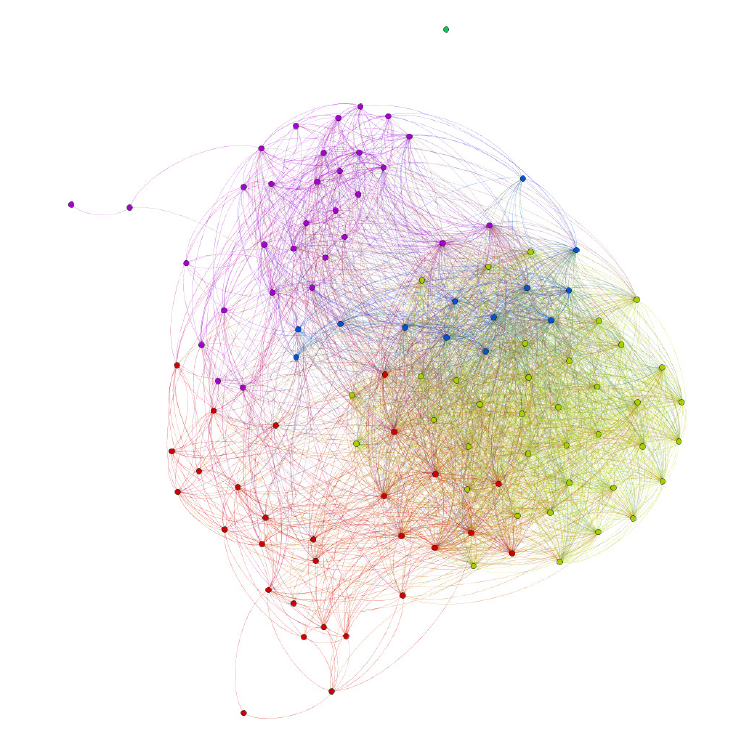
Figure 13. Communities in the network detected using a resolution of 1.